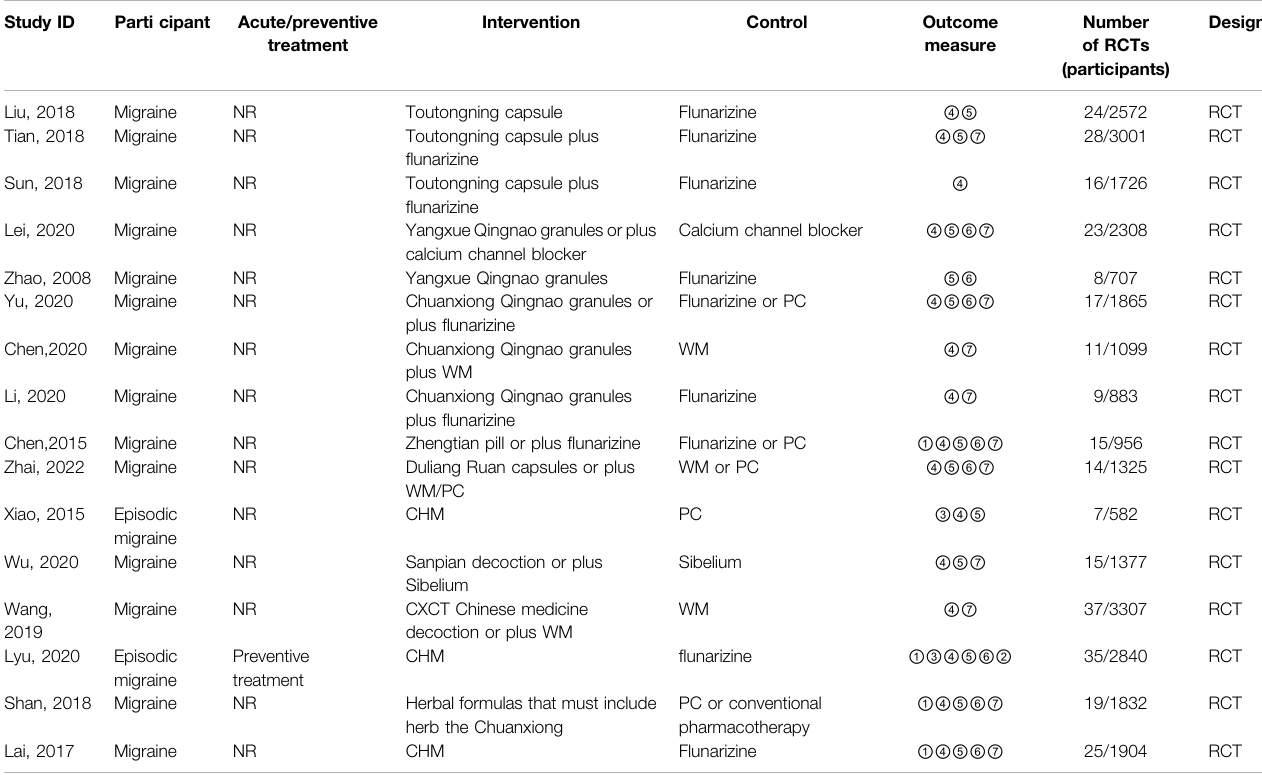
TABLE 2 | Systematic review/meta-analysis characteristics.